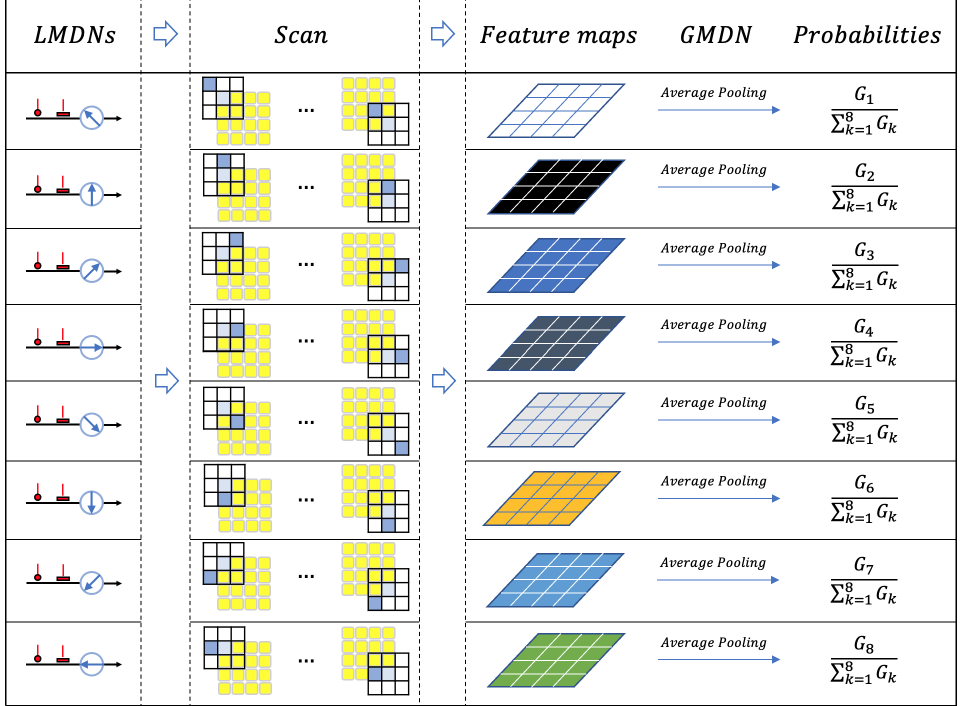
Figure 6. The global motion direction inferring process of GMDNs. Eight feature maps are given by scanning the input images using the eight corresponding LMDNs. GMDNs finnally give the probabilities by average pooling to eight feature